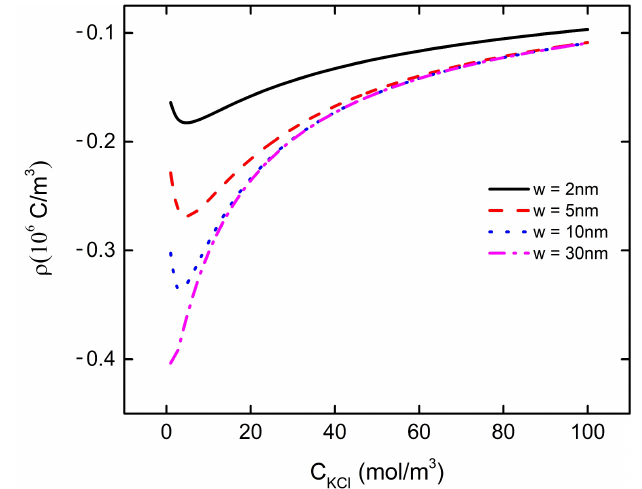
Figure 11. The curve of the total charge density in the PE brush layer at the bottom of the nanoparticle with the concentration of the background salt solution at di ff erent distances between the particle and the plate at pH =